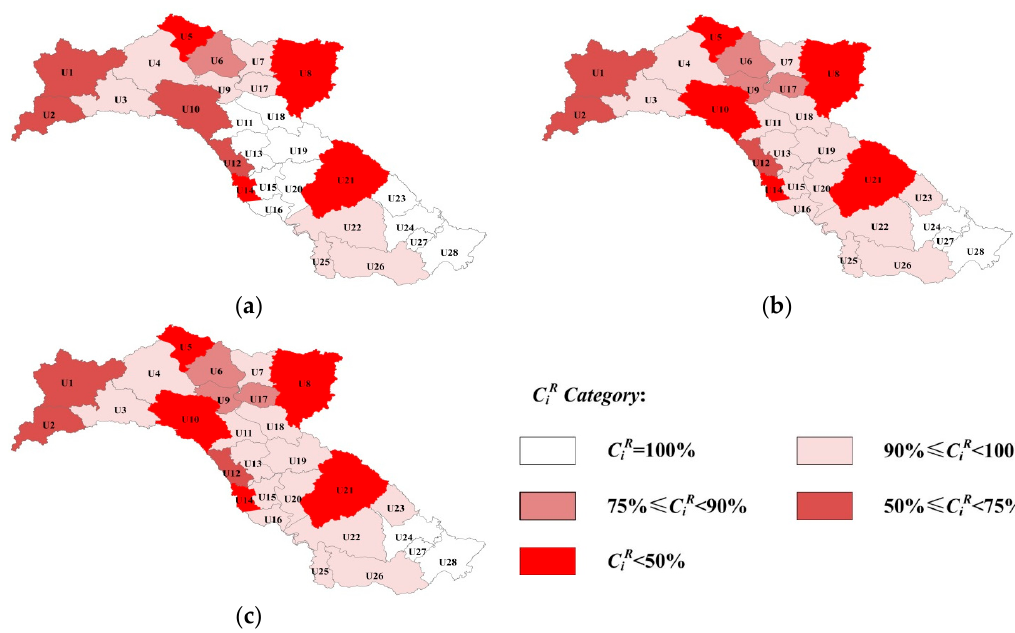
C categories in the MLHRB basin for different scenarios: ( a ) Figure 4. Spatial distribution of the R Figure 4. Spatial distribution of the C R categories in the MLHRB basin for different scenarios: i i present; ( b ) short ‐ term planning horizon; ( c ) long ‐ term planning horizon. ( a ) present; ( b ) short-term planning horizon; ( c ) long-term planning